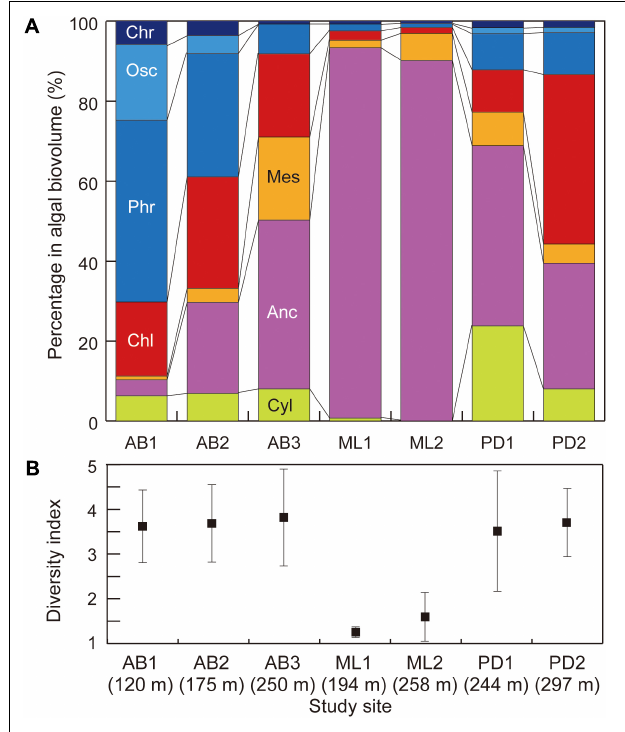
FIGURE 6 | Variations in (A) community structure (proportion of cell volume biomass) and (B) Simpson’s diversity index of phototrophs at the study sites on three glaciers in Svalbard. Abbreviation of algal name are Cyl, Cylindrocystis brébissonii ; Anc, Ancylonema nordenskiöldii ; Mes, Mesotaenium bregreni ; Chl, Chlamydomonas nivalis ; Phr, Phormidesmis priestleyi ; Osc, Oscillatoriaceae cyanobacterium; Chr, Chroococcaceae cyanobacterium. Error bar = standard